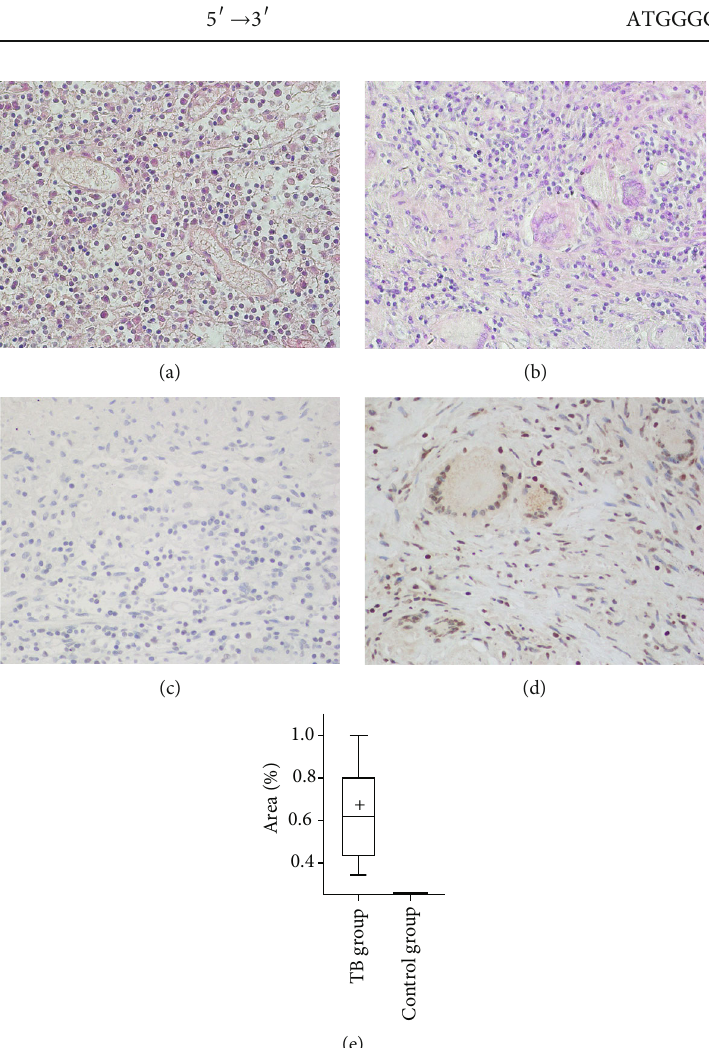
Figure 1: Pulmonary tuberculosis pathological staining. (a, b) Distal side control group and TB group hematoxylin and eosin staining ( × 200). (c – e) Distal side control and TB group immunohistochemistry staining ( × 200) and statistical